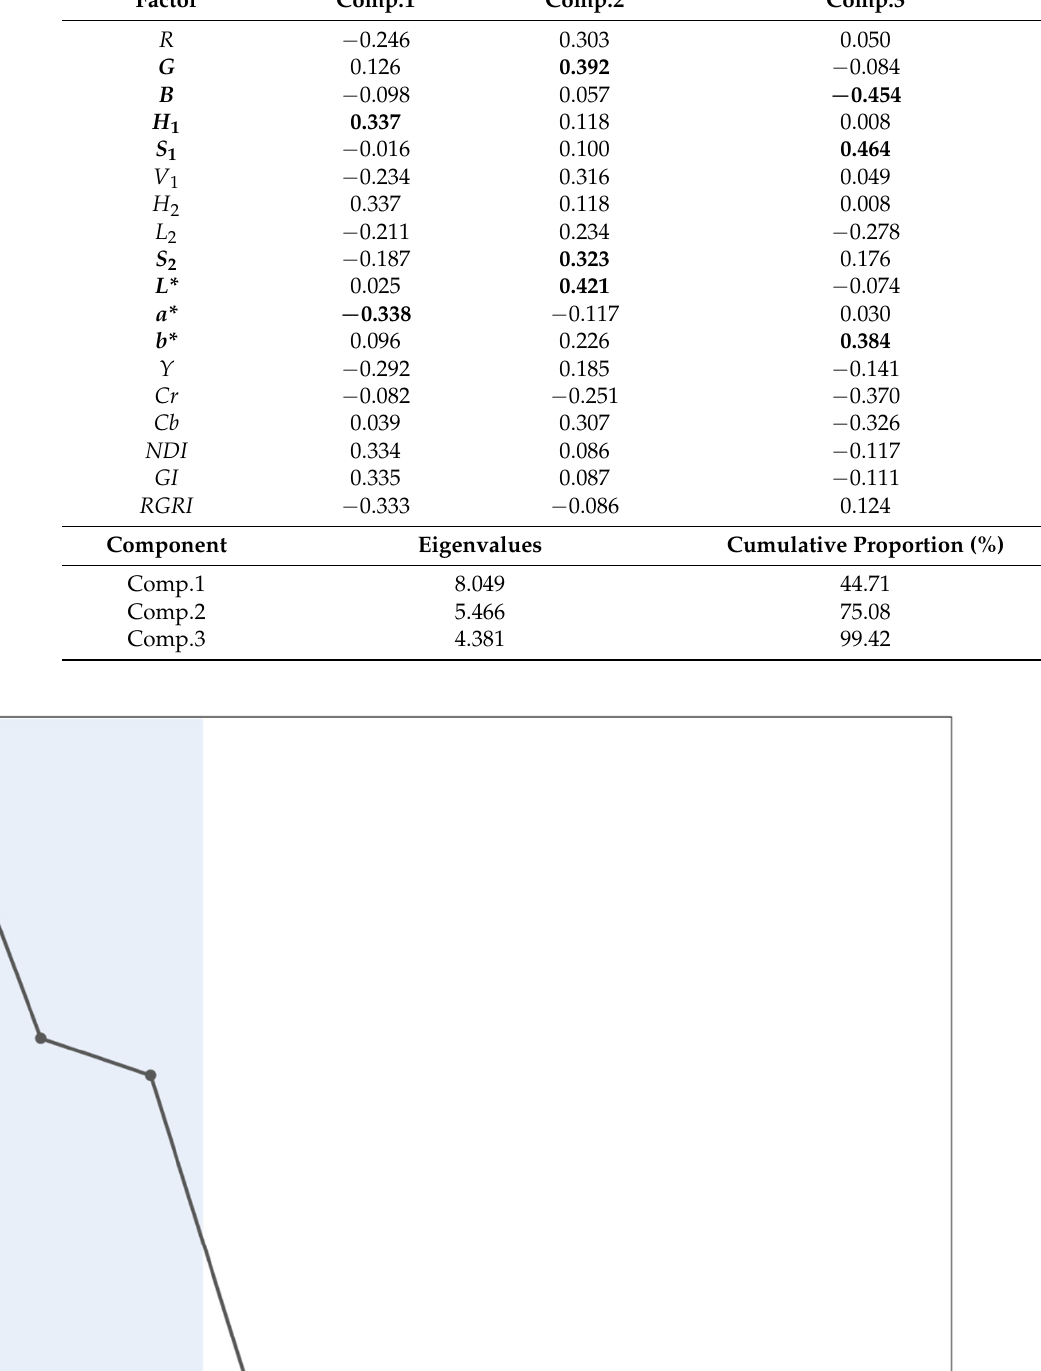
Table 3. Result of the principal component analysis by color index.